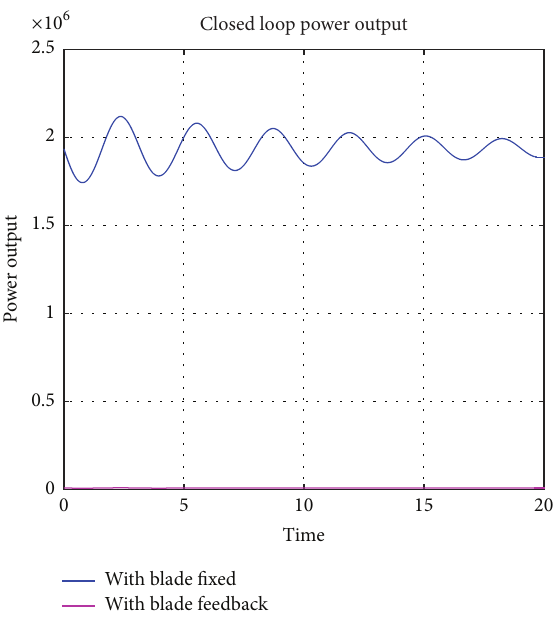
Figure 7: Response curves for the power output with the prescribed limit set at 700Kw.